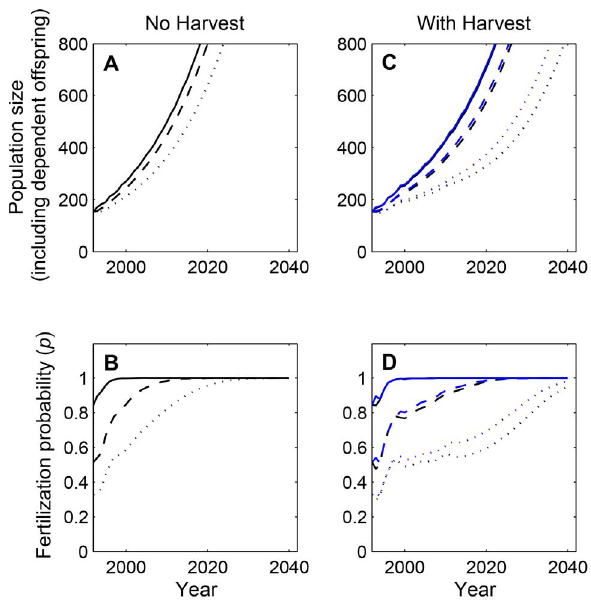
Figure 5. Population projections and corresponding fertiliza- tion probabilities for the Viscount Melville Sound population. All projections begin at the last day of the latest population census (1989–1992), and are initialized using the reported standing age/ reproductive-stage distribution. Models are parameterized using the life history parameters reported in [41], and the mating dynamics parameters of [15]. (A,B) Population projections for the (hypothetical) case of no harvest illustrating the maximum potential for population growth given the initial conditions in 1992, (C,D) population projections with the actual harvest rates included to the present and harvest continued into the future using current quotas. For both the ‘‘no- harvest’’ and ‘‘harvest’’ scenarios, we consider (i) a low-density case where polar bears are spread out through the entire available habitat within the population boundaries (dotted lines), (ii) an intermediate- density case where bears are concentrated in half of the available habitat (dashed lines), and (iii) a high density (mating aggregation) case where bears concentrate in , 15.5% of the available habitat area (solid lines). For the ‘‘harvest’’-scenario, two projections are shown for each density case, either assuming that all harvest occurs directly before (black) or directly after (blue) the mating